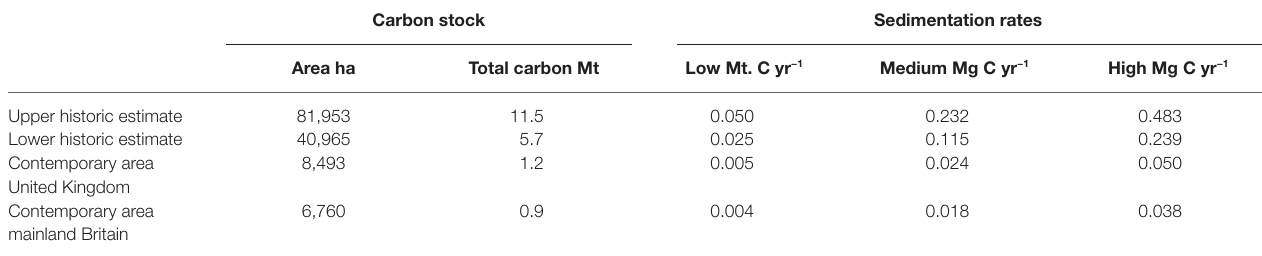
TABLE 6 | Estimates of total carbon (Mt C) of modeled historic and contemporary seagrass distribution of mainland Britain, and of contemporary seagrass distribution of the United Kingdom, with low (0.044 cm yr −1 ), medium (0.202 cm yr −1 ), and high (0.42 cm yr −1 ) estimates for carbon sedimentation per year (Mg C yr. −1